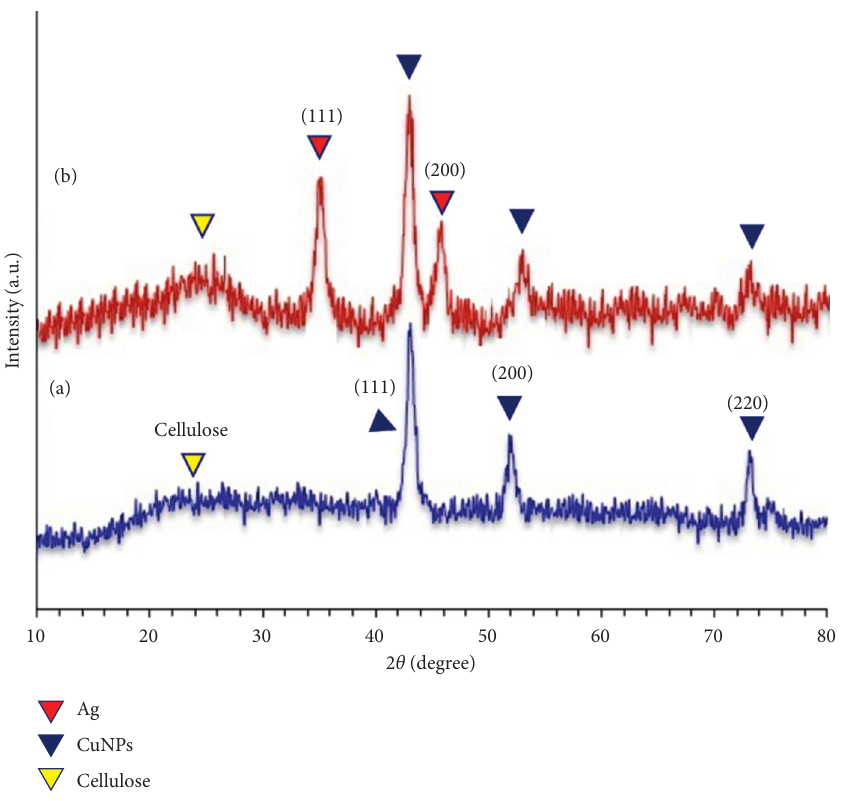
Figure 5: XRD pattern of the biosynthesized CuNPs: (a) using pistachio hull extract and CSS NC